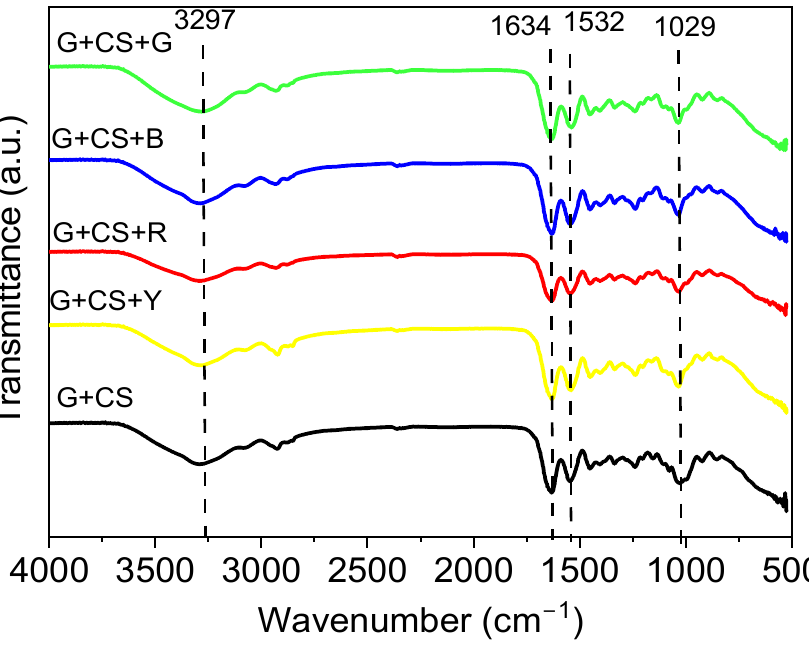
Figure 2. Fourier transform infrared (FTIR) spectrum of films. The black line denotes G+CS, the yellow line denotes G+CS+Y, the red line denotes G+CS+R, the blue line denotes G+CS+B, and in the green line denotes G+CS+G.